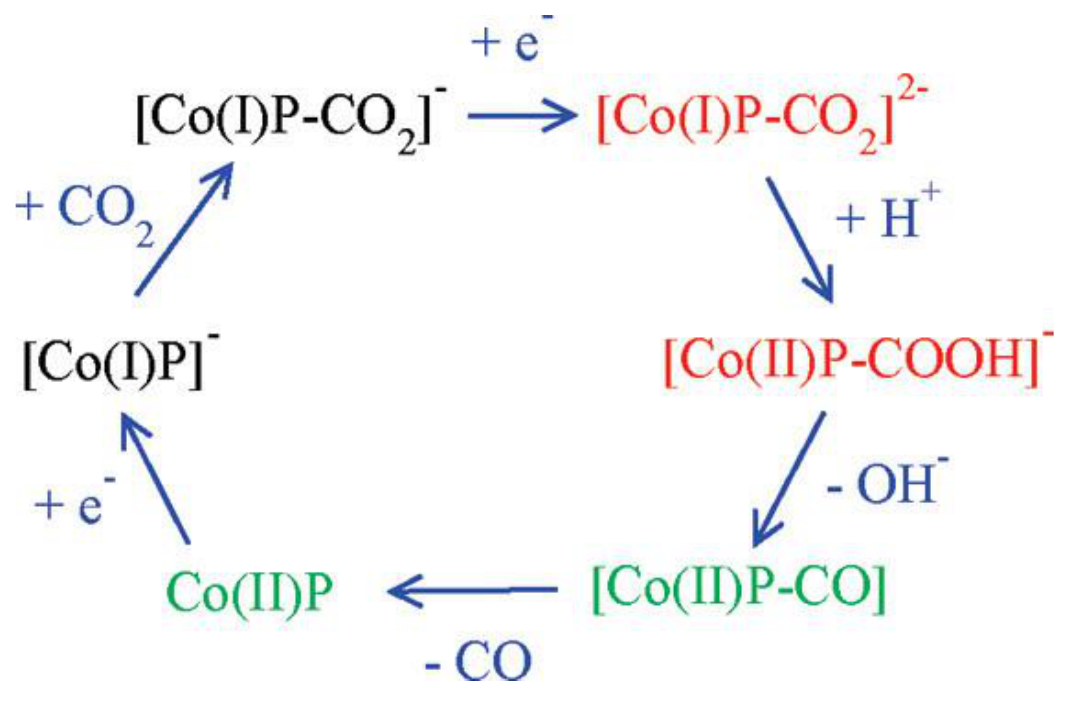
Figure 12. Mechanism of CO 2 reduction with electron addition deduced from hybrid DFT plus dielectric continuum redox potential calculations. Red denotes key intermediates; green species should undergo fast reactions. Reprinted from Ref. [126], copyright (2010), with permission from the American Chemical Society.